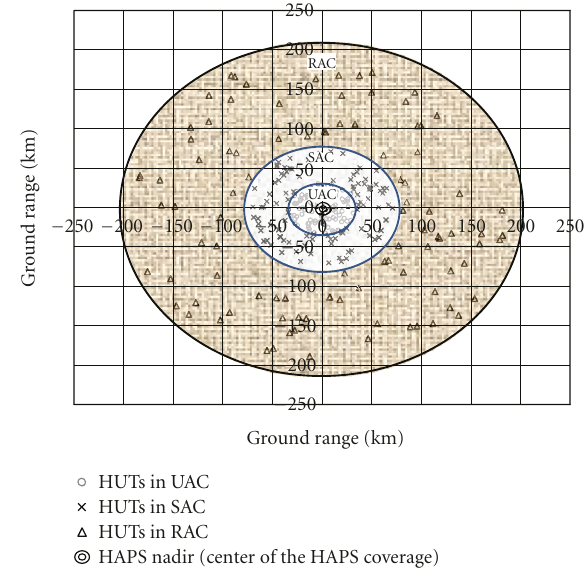
Figure 2: An example of HUT distribution.